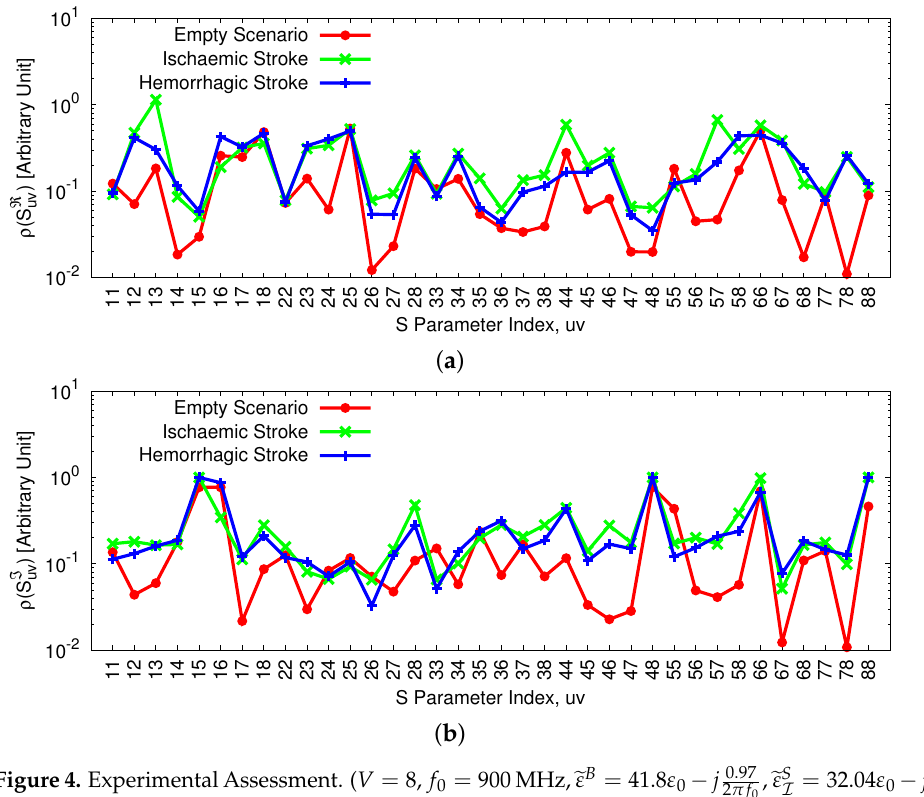
, (cid:101) ε S I = 32.04 ε 0 − j 0.85 2 π f 0